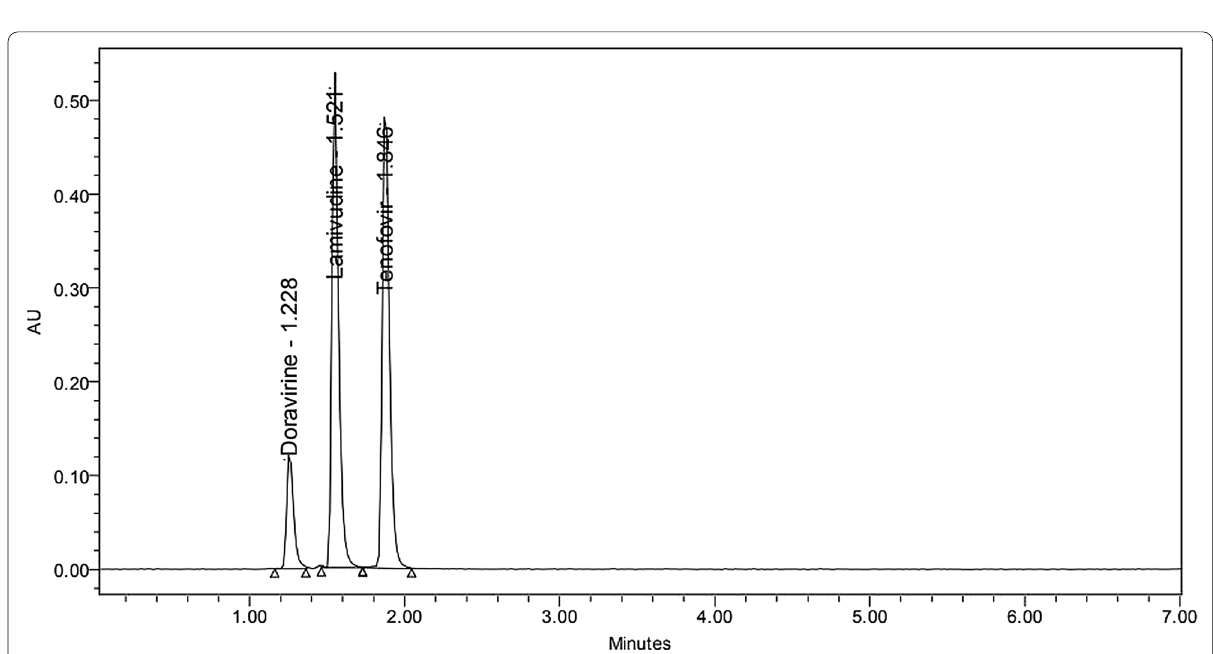
Fig. 8 Chromatogram of the oxidative degradation